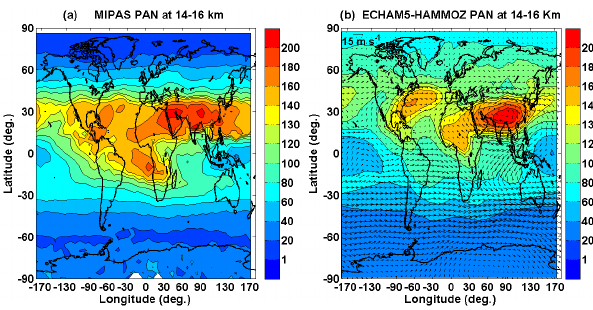
Figure 3. Distribution of seasonal mean PAN concentration (ppt) averaged for 14–16km (a) observed by MIPAS-E (climatology for the period 2002–2011) (b) ECHAM5–HAMMOZ CTRL simula- tions. Wind vectors at 16km are indicated by black arrows in (b)